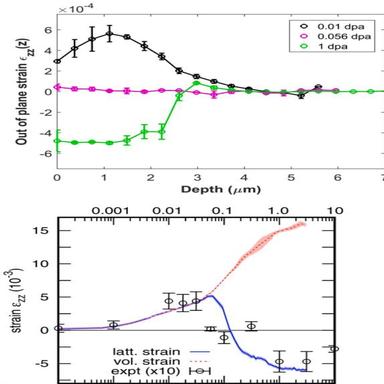
(Top) Depth-resolved strain in tungsten irradiated with 20 MeV selfions, measured using diffracted X-ray intensity of the Bragg peak for three values of radiation exposure. The fact that the observed strain changes sign from positive at low dose to negative at high dose is an example of irreversible radiation-driven structural and stress relaxation . (Bottom) Experimentally observed strain plotted as a function of dose, compared with atomistic simulations performed using the Creation-Relaxati